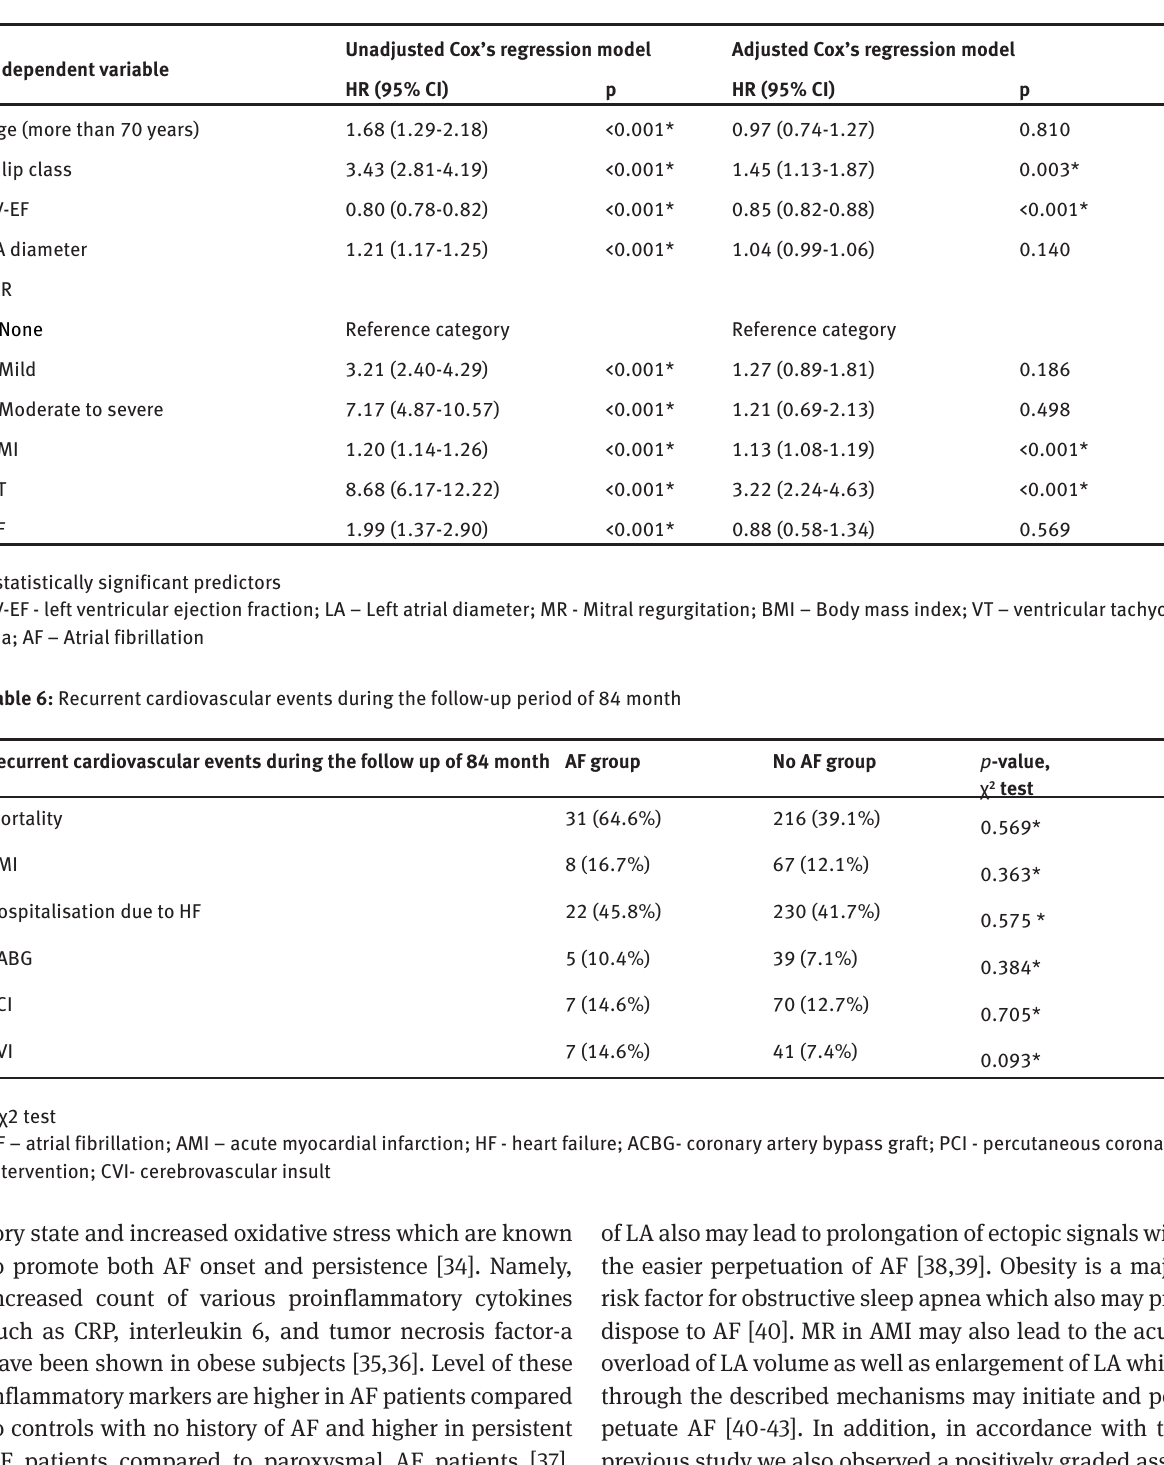
Table 5: Cox’s proportional hazards model for mortality during the follow-up period of 84 months